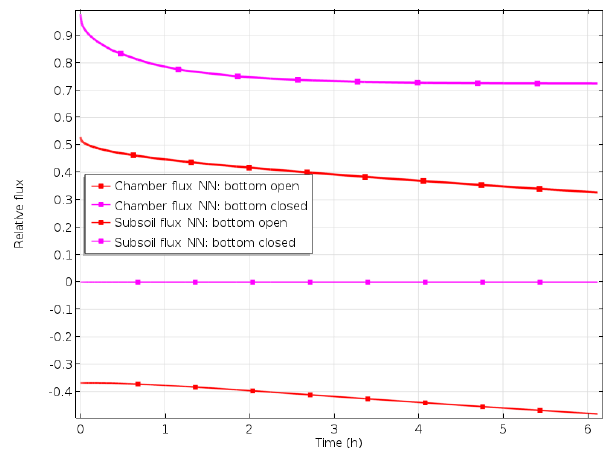
Figure 6. Simulated time course of surface and subsurface fluxes with the open bottom or closed bottom (scenario A_bottom_open and A_bottom_closed at SWC =